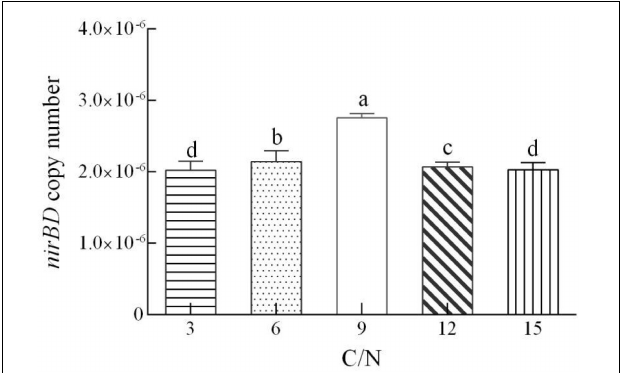
FIGURE 4 | Quantitative measurement of the nirBD expression in Pseudomonas putida Y-9 cultured with different C/N ratios (with glucose as the sole carbon source) for 4 d. The values are expressed as the number of copies/10 10 copies of 16S rRNA. The different lowercase letters above the bars indicate significant differences among treatments ( P < 0.05).